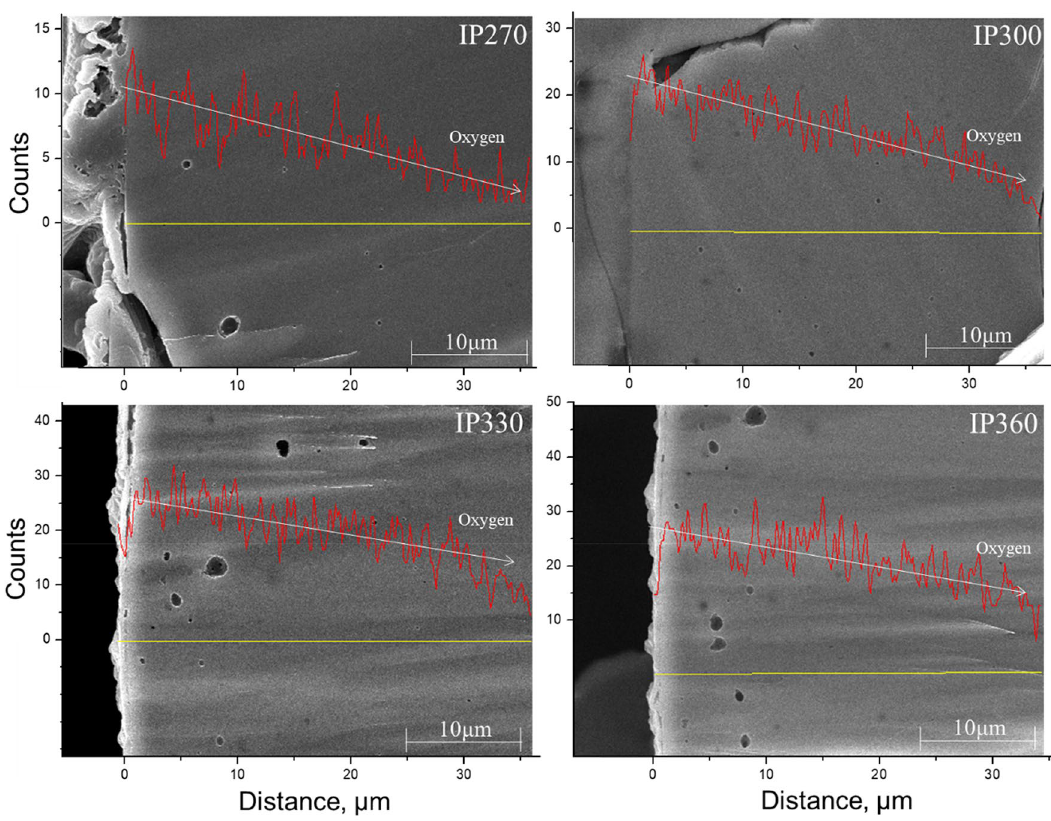
Figure 2. Oxygen uptake of surface oxidized pitch at various surface oxidation